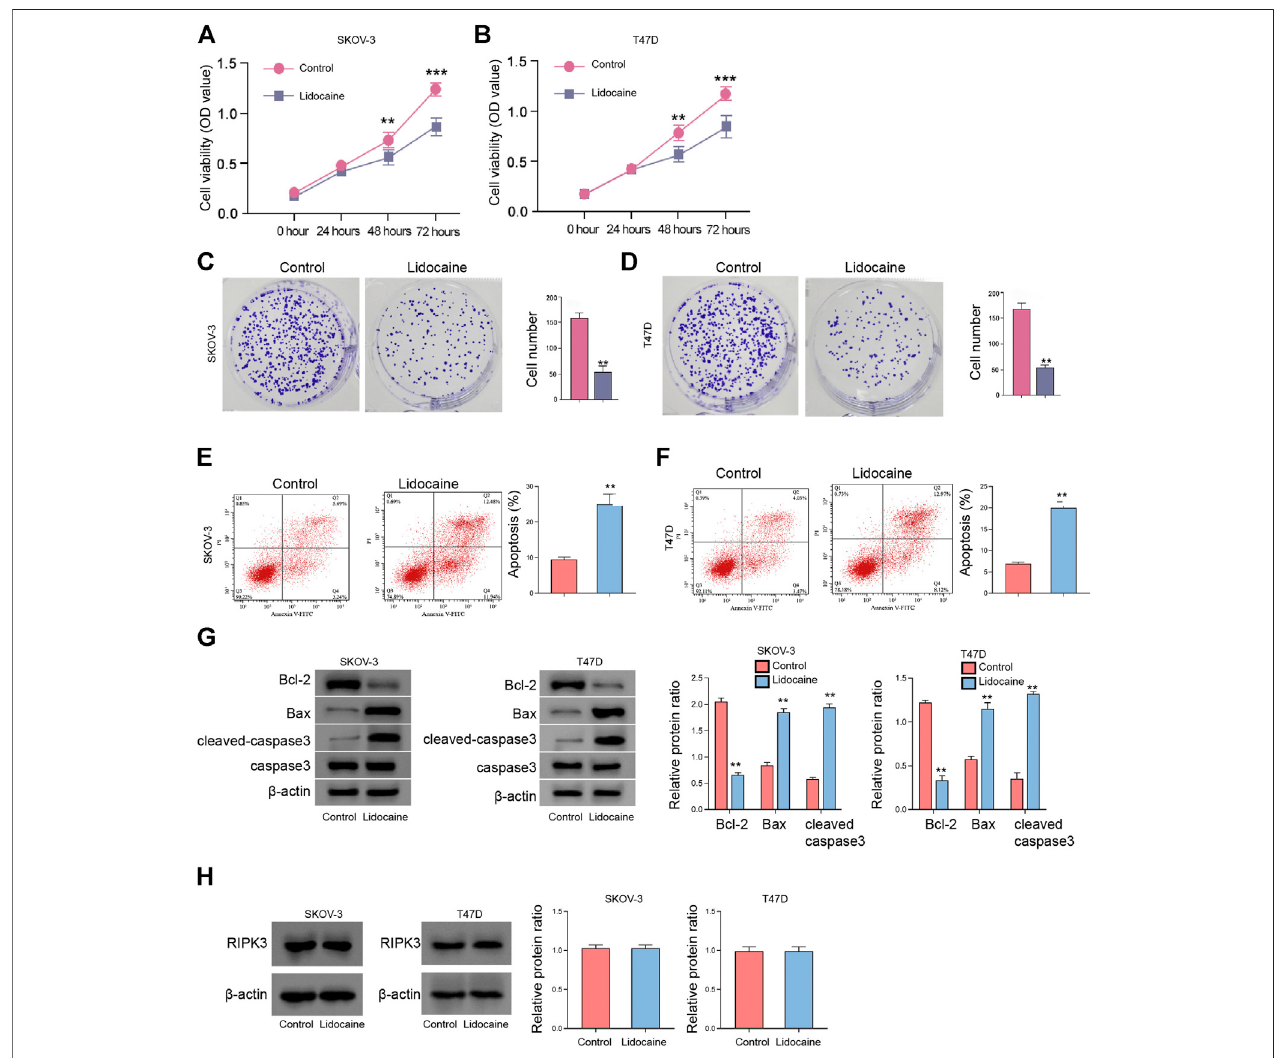
FIGURE 2 | Lidocaine reduces the proliferation of ovarian and breast cancer cells in vitro . (A – H) SKOV-3 and T47D cells were treated with lidocaine (3 mM). (A , B) The cell viability was detected by MTT assays. (C,D) The cell proliferation was measured by colony formation assays. (E,F) The apoptosis was analyzed by fl ow cytometry. (G) The expression of Bcl-2, Bax, caspase3, and cleaved-caspase3 was detected by Western blot. The results were quanti fi ed using ImageJ software. (H) The expression of RIPK3 was measured by Western blot. The results were quanti fi ed using ImageJ software. mean ± SD, ** p < 0.01. The experiments were performed independently three